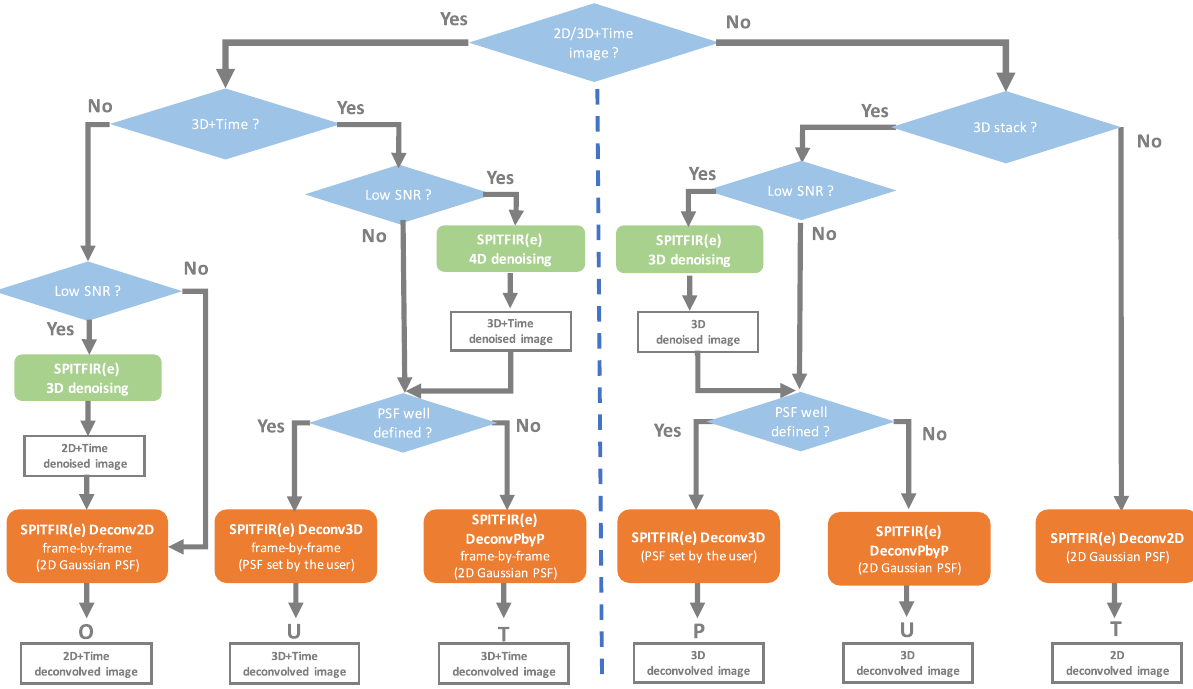
Figure 1. SPITFIR(e) overview. The flow chart describes the sequence of restoration steps applied to 3D, 2D+Time, or 3D+Time images based on responses of